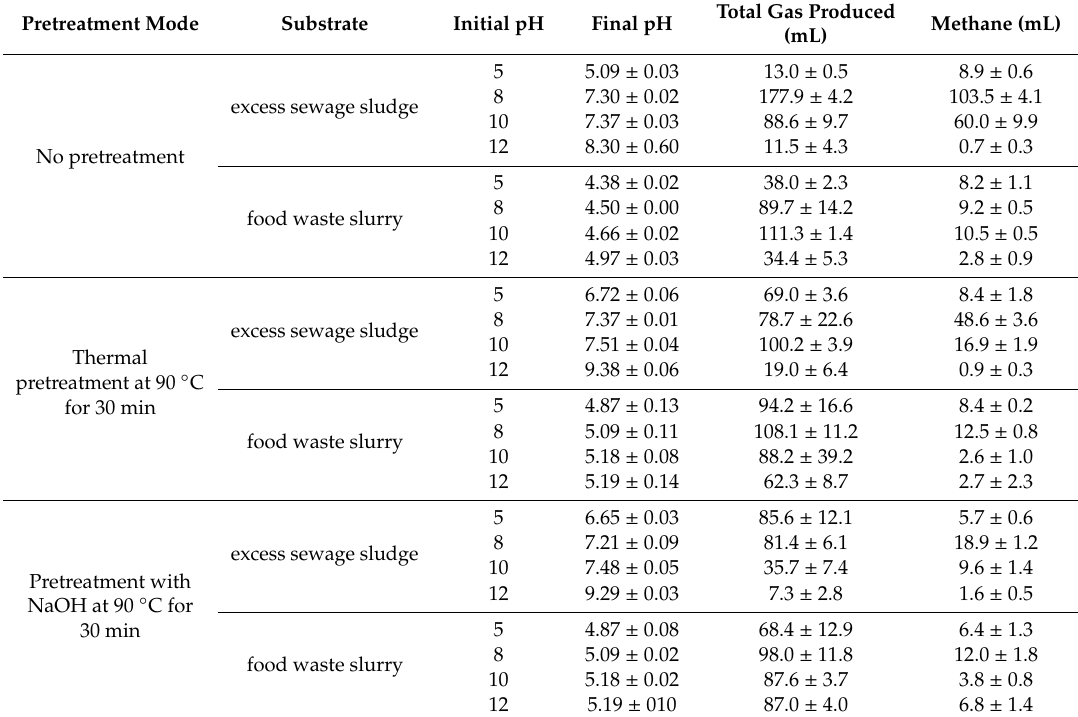
Table 2. Batch reactors’ initial pH, final pH, and gas products